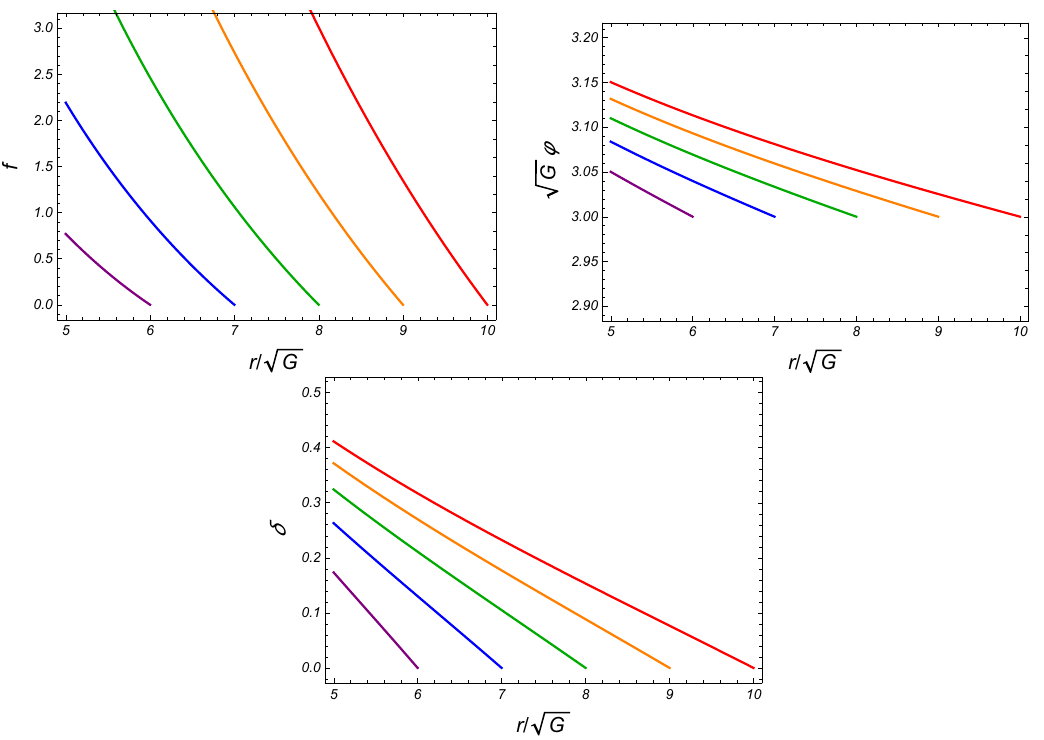
√ √ √ √ G, 7 G, 8 G, 9 G , and 10 √ G